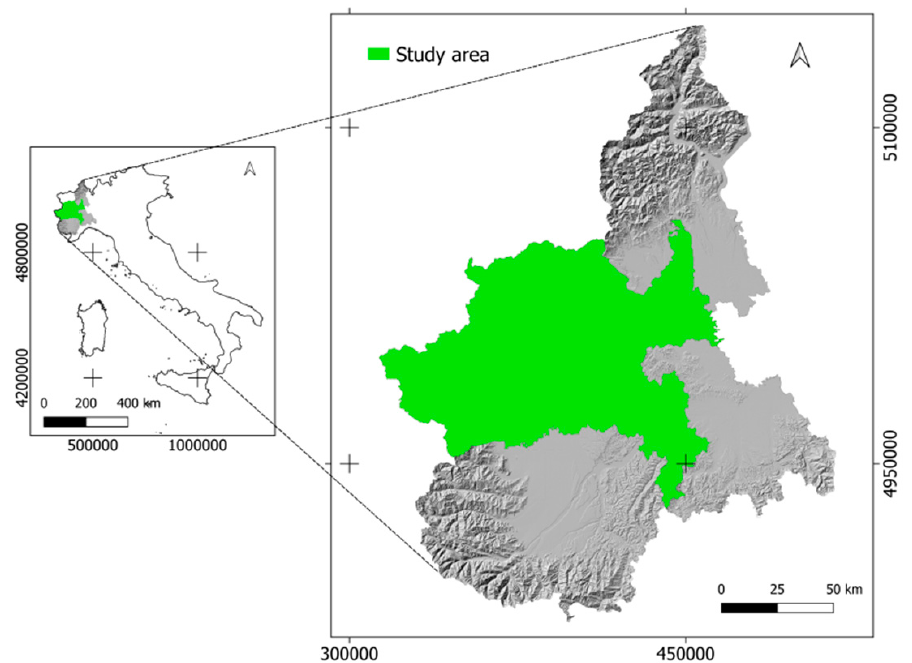
Figure 1. The study area (green) is located in the Piemonte Region of NW Italy and corresponds to the administrative provinces of Torino, Asti and, partially, Vercelli. (Reference system is WGS84/UTM 32N, EPSG: 32632).